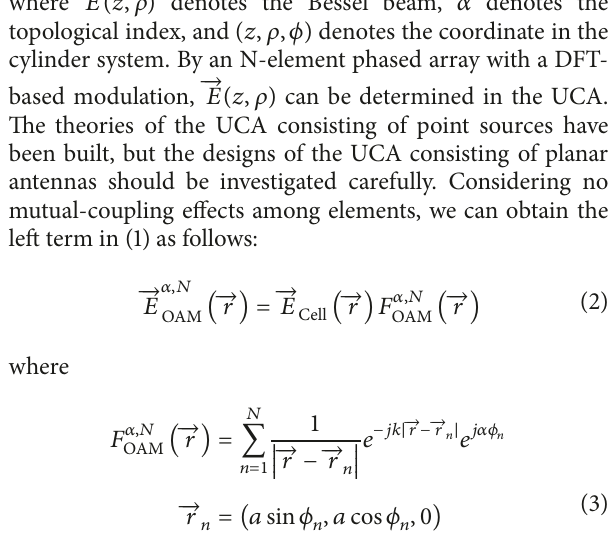
Table 1: Parameters of the generator (unit: